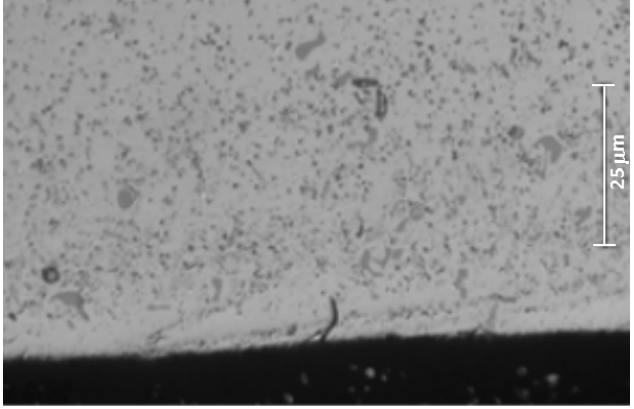
Figure 12. Cracks that radiate